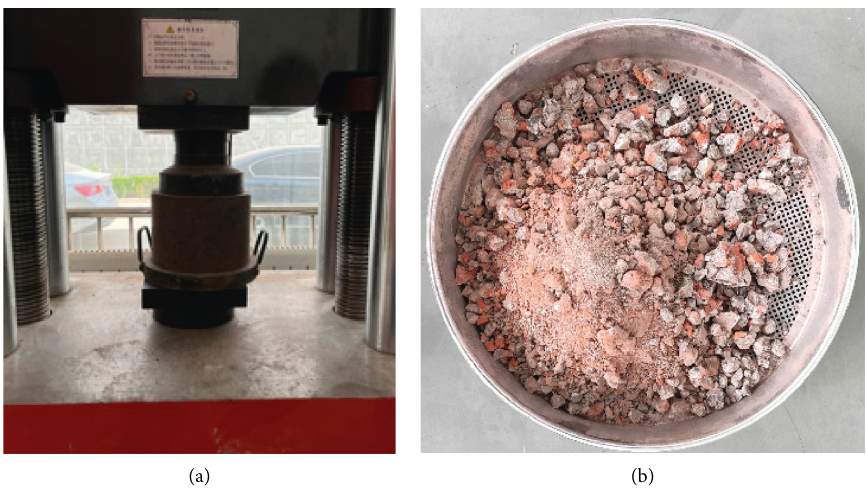
Figure 3: Crushing value test. (a) Aggregate crushing and (b)crushed aggregate